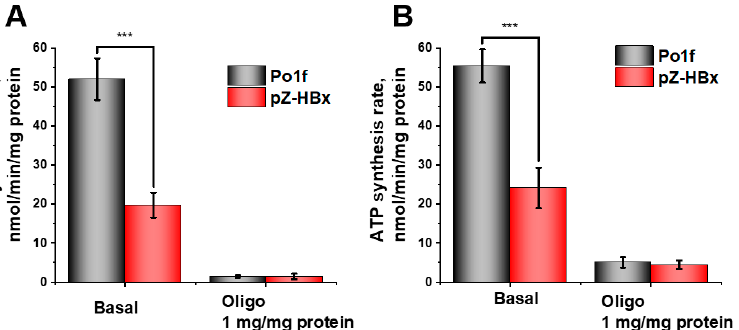
Figure 9. ATP production by Y. lipolytica mitochondria. ( A ) The basic incubation medium was sup- plemented with 5 μ M Phenol Red, 6 μ M Ap5A (an inhibitor of adenylate kinase), and mitochondria (0.2 mg protein/mL); ( B ) The basic incubation medium was supplemented with 6 μ M Ap5A, 1 mM glucose , 1 mM NADP, hexokinase (10 U/mL), glucose-6-phosphate dehydrogenase (3 U/mL), and mitochondria (0.2 mg protein/mL). The statistical analyses were carried out by the one-way ANOVA test. ***: p < 0.001.